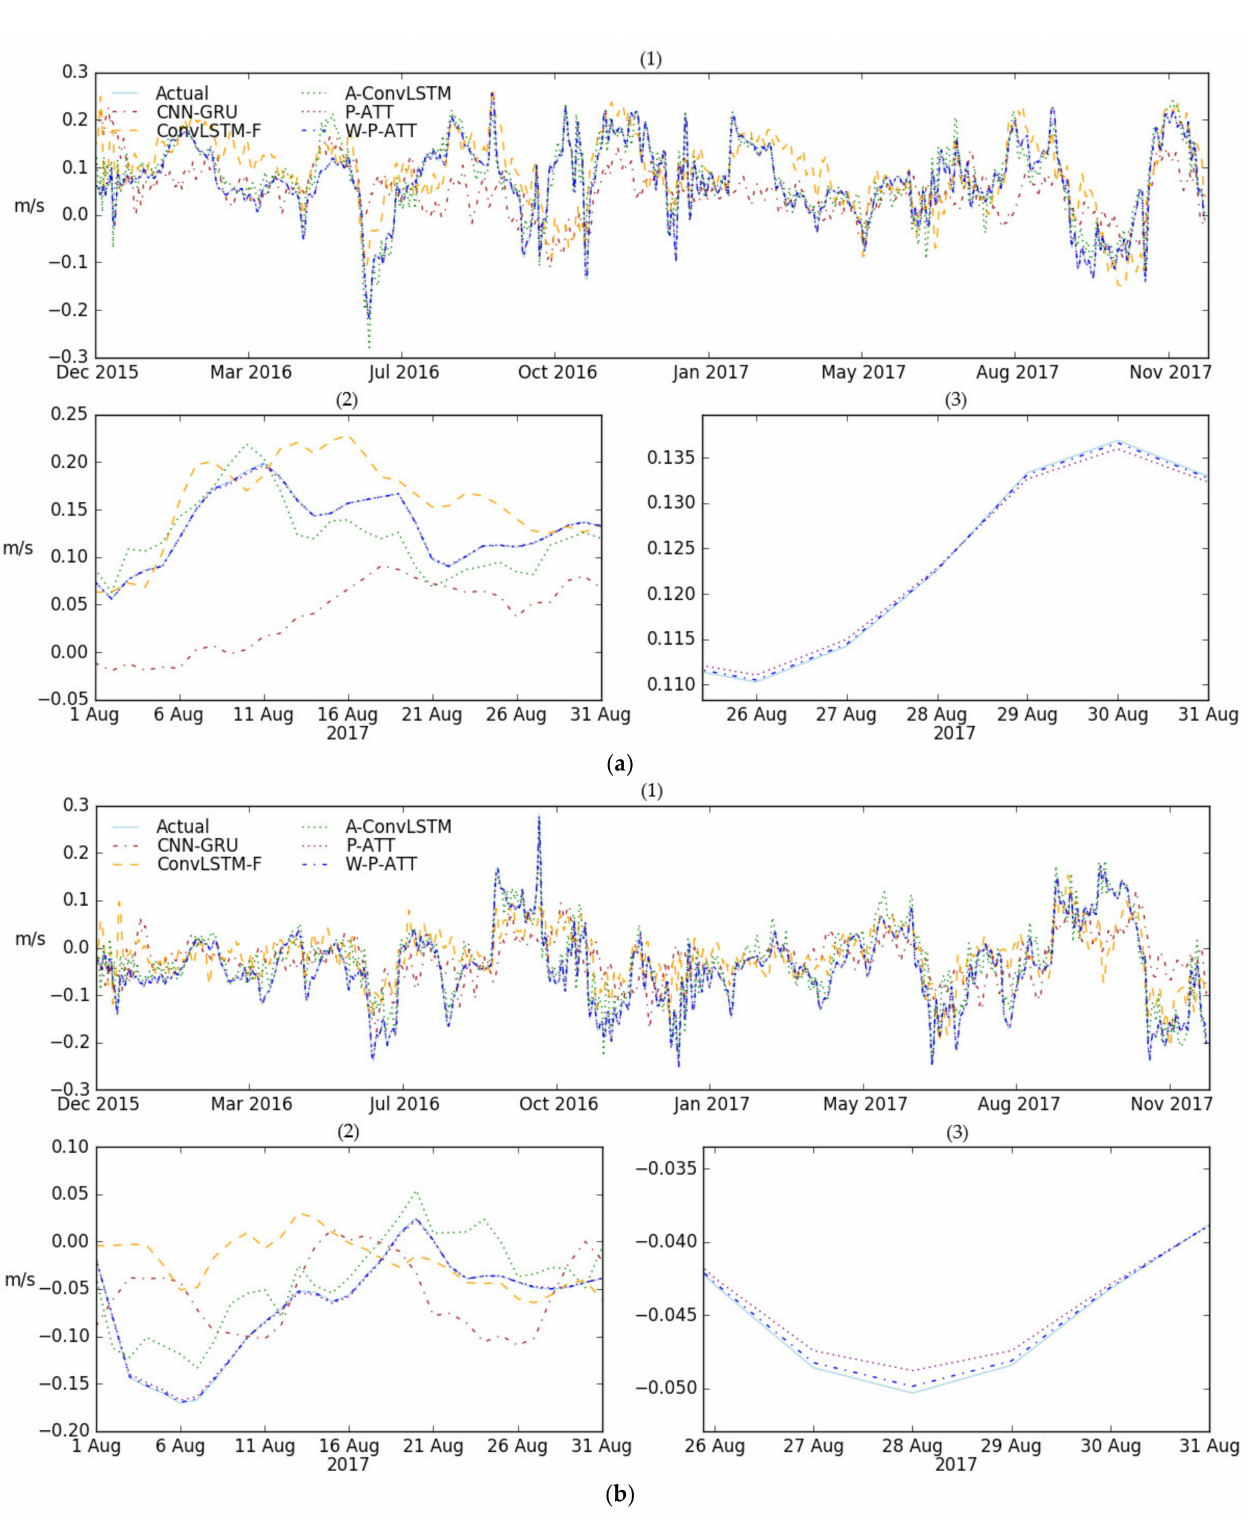
Figure 9. The comparison between the predicted OCs and observed OCs for spatial point (125.75 ◦ E, 27.125 ◦ N)—( a ) u_current, ( b ) v